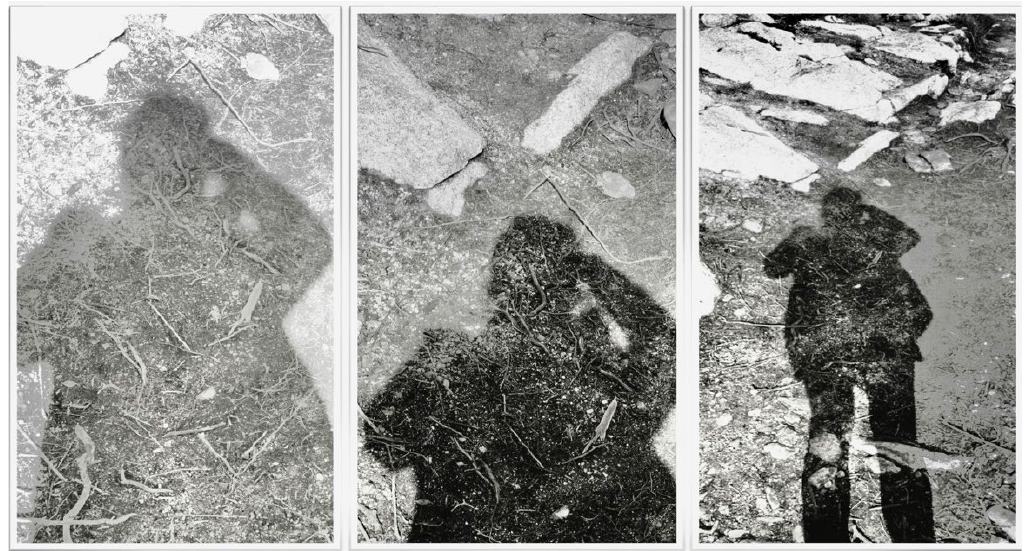
Figure 5 . I am an extension of the